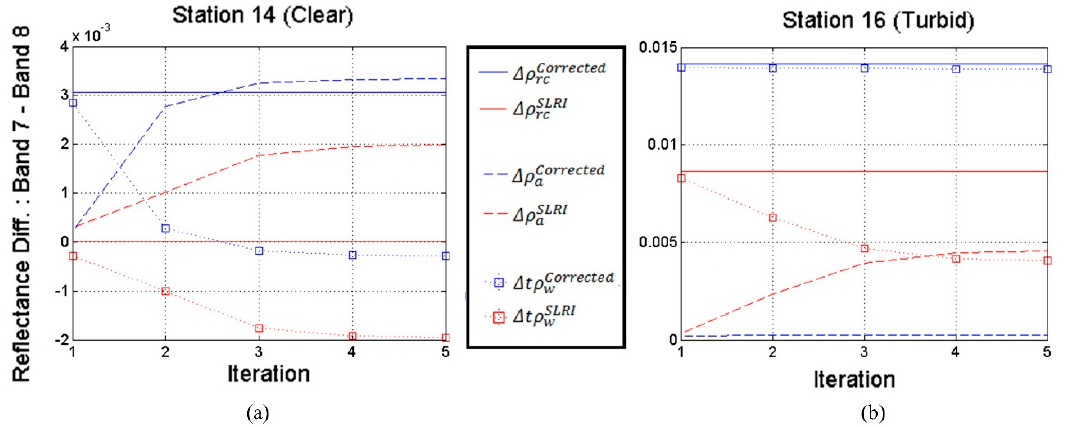
Figure 7. Changes in ∆ ρ rc , ∆ ρ a , and ∆ t ρ w over the final five iterations in the aerosol estimation process for ( a ) Station 14; and ( b ) Station 16.